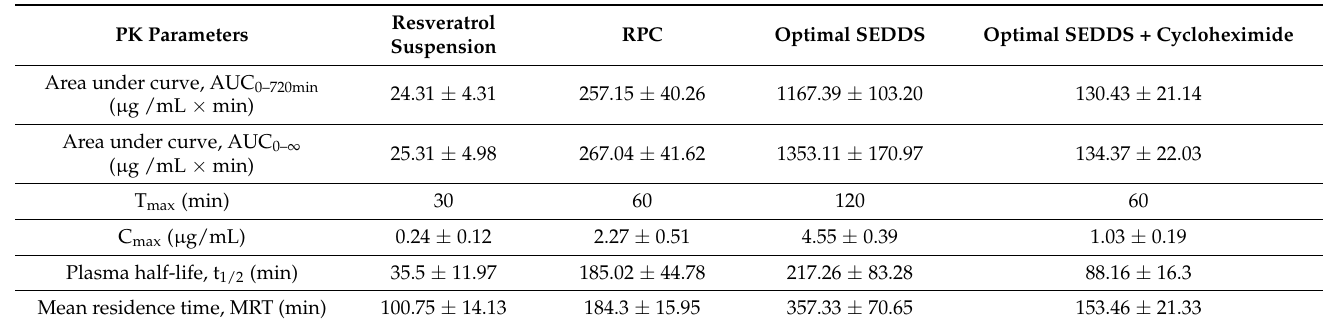
Table 4. Pharmacokinetic parameters of resveratrol in rat plasma. (Data represented as Mean ± SD, n =